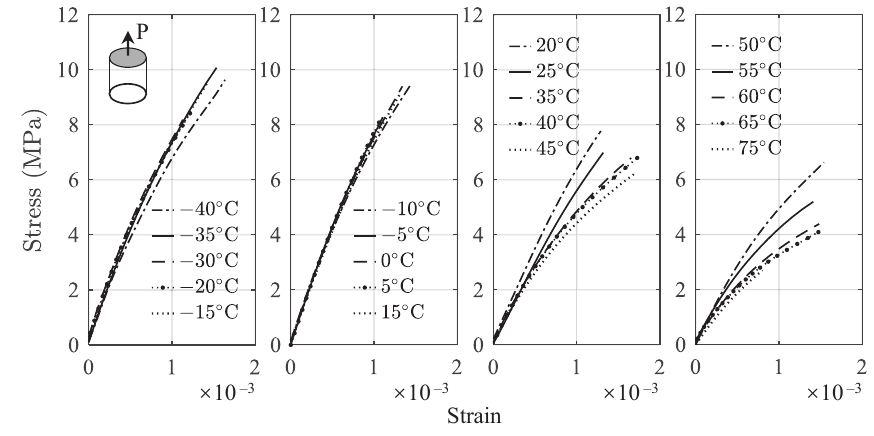
Figure 4. Stress–strain curves under tension.